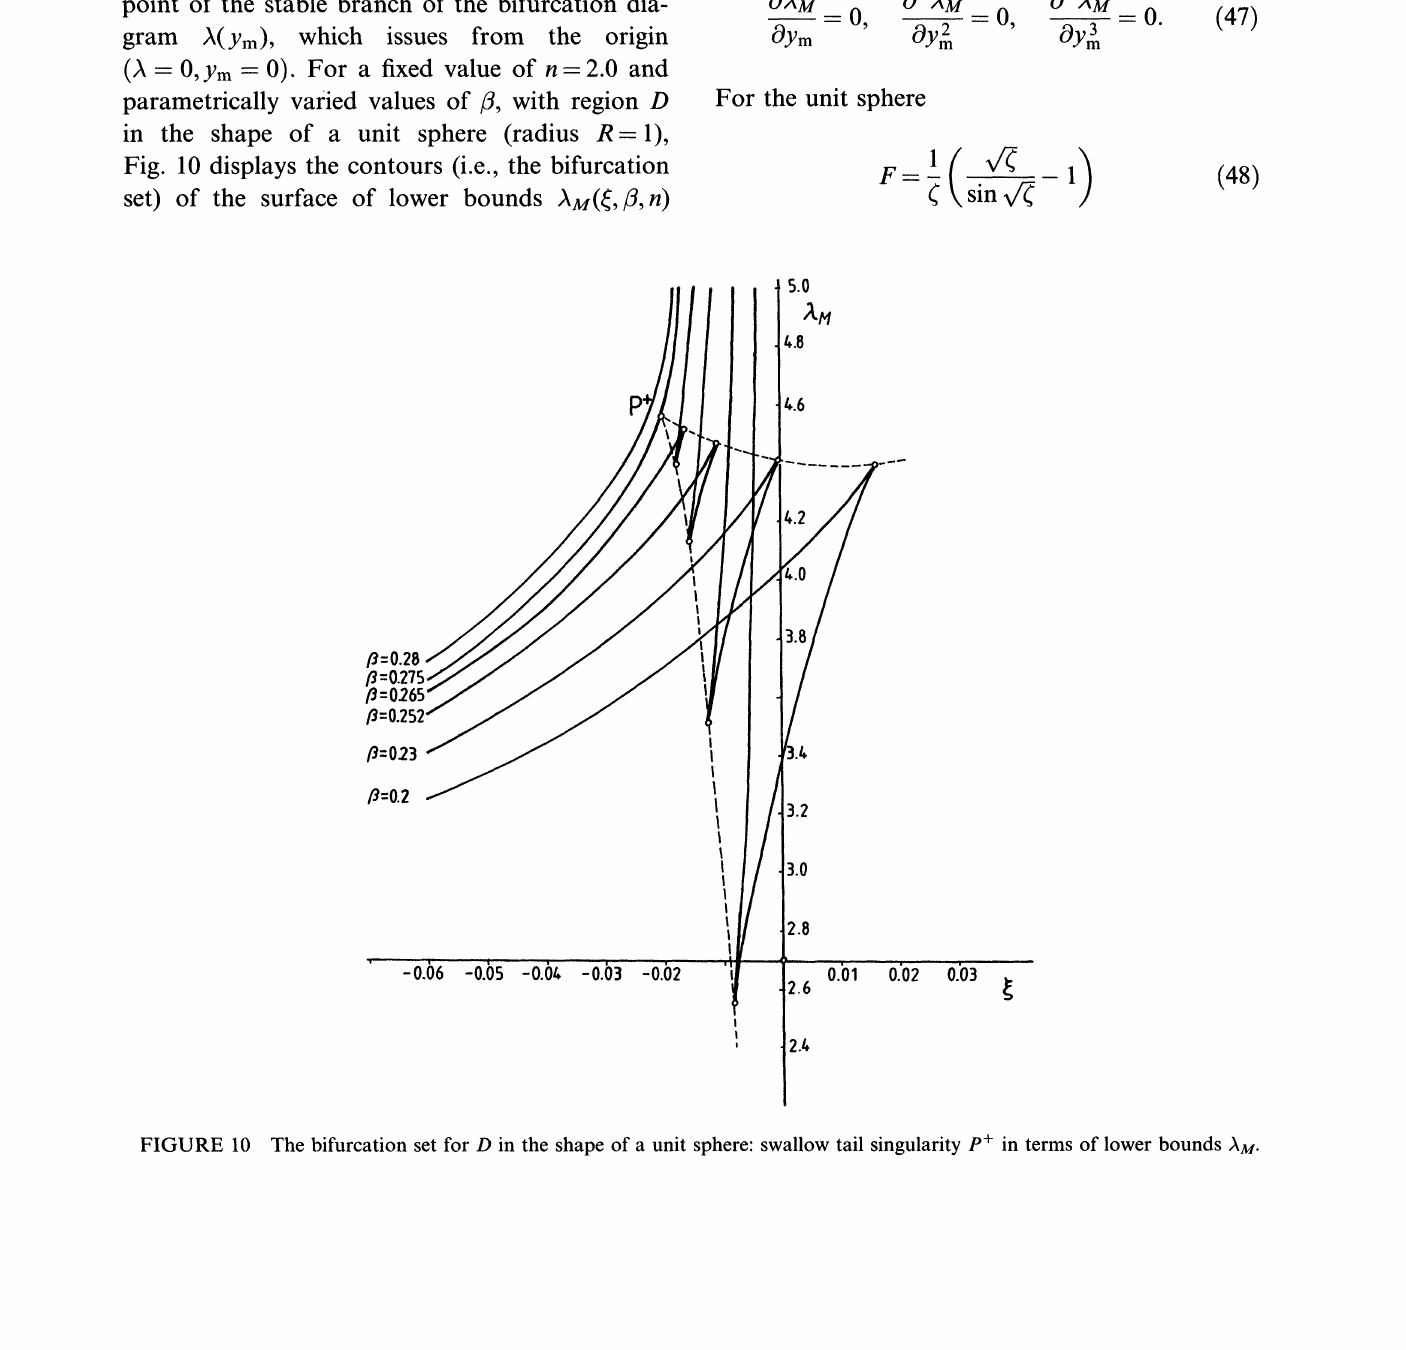
FIGURE 10 The bifurcation set for D in the shape of a unit sphere: swallow tail singularity P+ in terms of lower